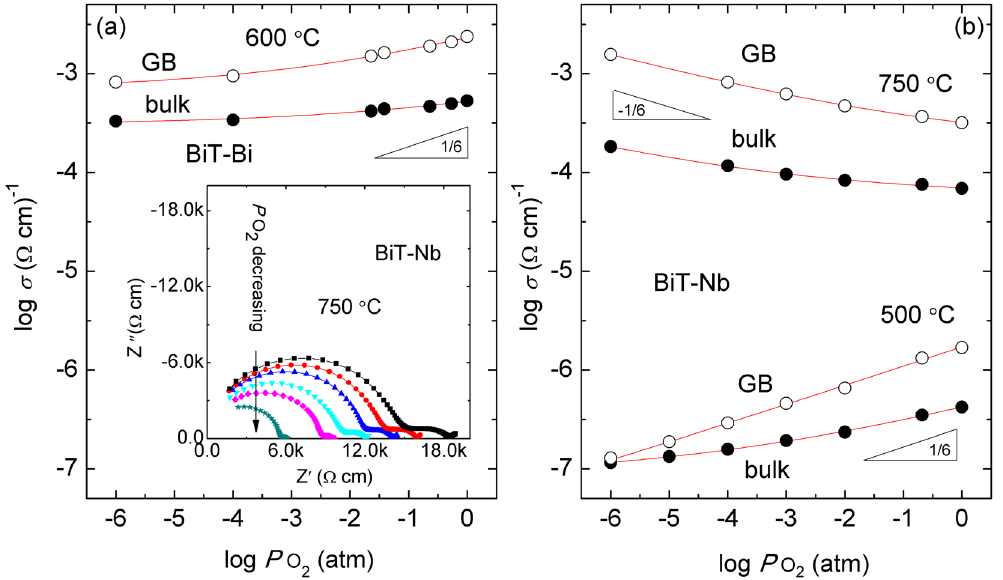
Figure 9. pO 2 dependences of σ bulk and σ GB of BiT-Bi and BiT-Nb. ( a ) BiT-Bi at 600 °C, ( b ) BiT-Nb at 500 °C and 750